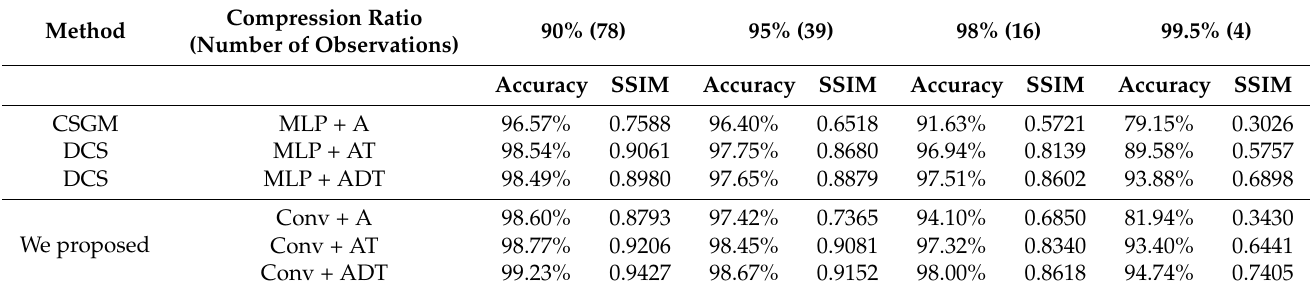
Table 9. Comparison of Fashion_MNIST reconstruction accuracy results.